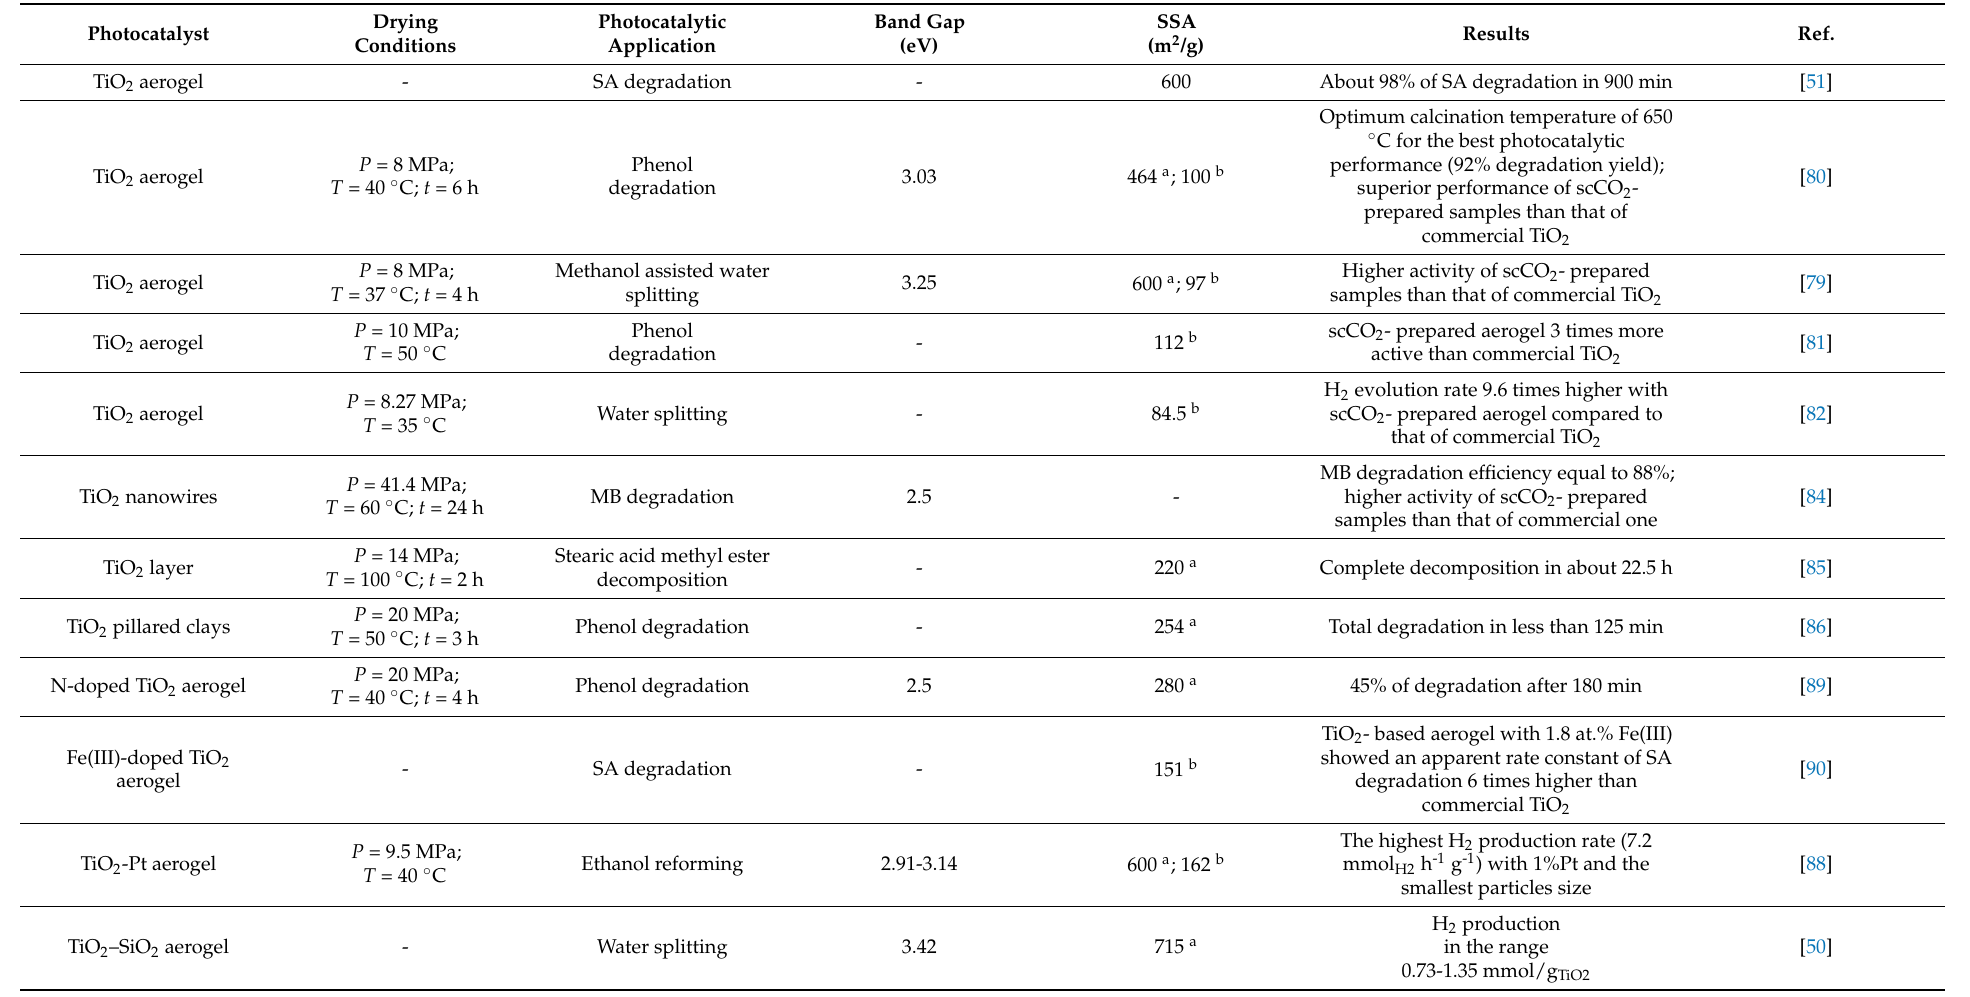
Table 3. Synthesis of photocatalysts by sol–gel reaction and supercritical drying. SSA = specific surface area; RFCA = resorcinol-formaldehyde carbon aerogel; MB = methylene blue dye; MO = methyl orange dye; NPs= nanoparticles; RF= resorcinol-formaldehyde; SA: salicylic acid; s-PS = syndiotactic polystyrene; VOCs = volatile organic compounds; P = operating pressure; T = operating temperature; t = drying